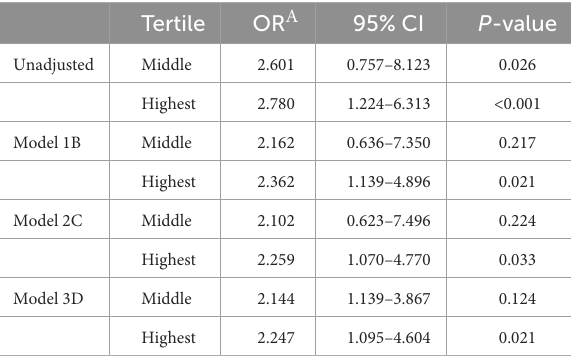
TABLE 5 Unadjusted and adjusted associations between quartile of SAA levels and poor outcome at 90 days. Tertile